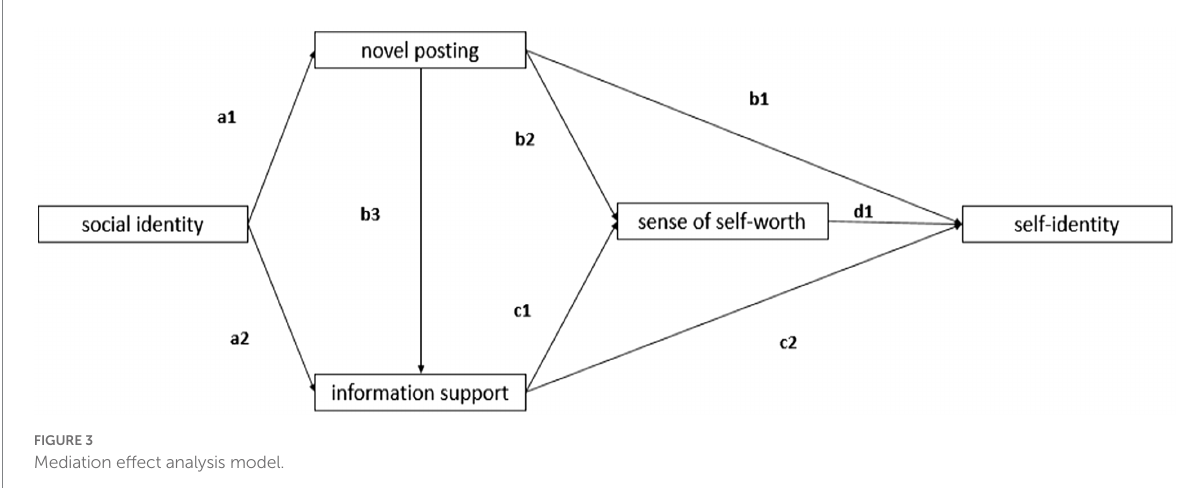
FIGURE 3 Mediation effect analysis model.